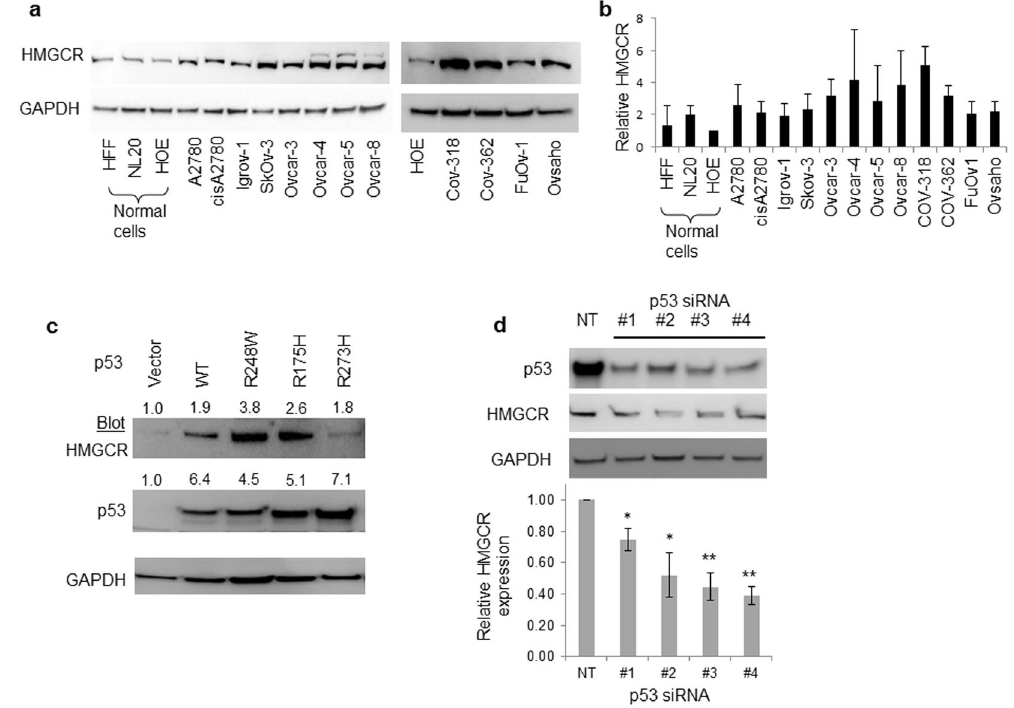
Figure 1. HMGCR is over-expressed in ovarian cancer cells and regulated by TP53 . ( a ) The expression of HMGCR was measured by immunoblotting and quantified ( b ) in a panel of ovarian cancer cells and compared to non-cancerous cells including normal human ovarian epithelia (HOE), human foreskin fibroblasts (HFF) normal lung epithelia (NL20). ( c ) Wild (WT) and TP53 variants were over-expressed in SkOv-3 cells and p53 and HMGCR measured by immunoblotting. The numbers above the blots show the mean change in protein normalized to GAPDH (n = 3 lysates) and expressed as ratio of that measured in cells transfected with the vector. D. Ovcar-3 cells were transfected with non-targeting (NT) siRNA or 4 different p53 siRNA (#1, #2, #3, #4) and reduction in p53 and HMGCR protein confirmed by immunoblotting (n = 3 independent transfections). Expression was quantified and normalized to that in normal cells (mean ± S.D, n = 3, * paired t - test, P < 0.05, compared to cells transfected with vector). HMGCR mRNA was measured by QPCR, normalized to GAPDH expression and expression was calculated as a fraction of that measured in cells transfected with NT siRNA (paired t -test, n = 3 independent transfections; * P < 0.05; ** P < 0.005 compared to cells transfected with NT siRNA). Images presented in this panel were cropped to remove surrounding white space.